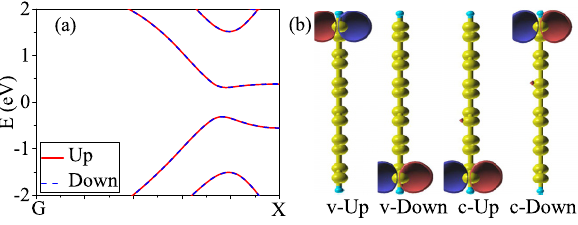
Figure 3: (a) The band structure of 6-ZGNR in the ground state; (b) the real space distribution of the edge states in the valence band ( 𝑣 ) and the conduction band ( c ) at the X point. ‘Up’ and ‘Down’ mean spin up and spin down components, respectively.